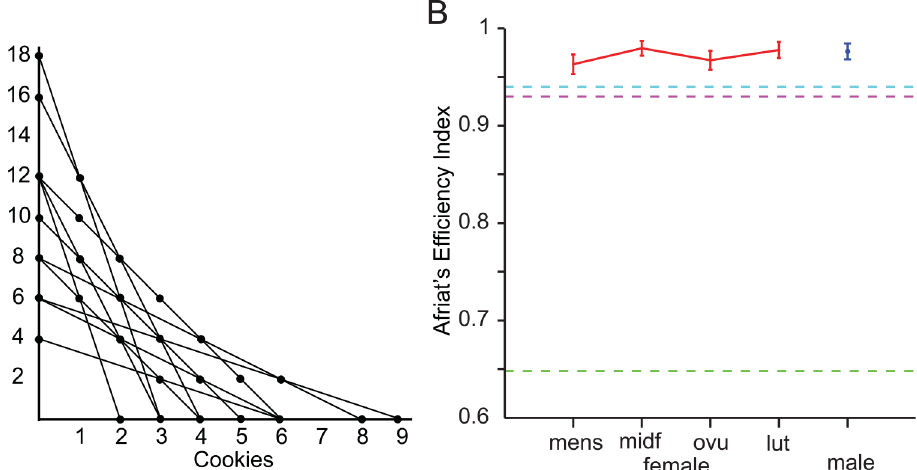
Fig 2. Results from the GARP experiment. (A) Budget sets used in the GARP experiment. Each line represents one budget set and circles on the line represent the bundles (or options) amongst which the subject can make a selection. ( B) Rationality across the menstrual cycle. Measures of the Afriat ’ s Efficiency Index are plotted for subjects in each menstrual cycle phase and for an age-matched male control population (both n = 36 subjects). Measures for all phases were above 0.95, the common threshold for rationality, and not significantly differently across phases or compared to males (all p > 0.3). Error bars represent standard errors. The dotted lines represent the AEI measurements for a random chooser (green) second grader (pink) and undergraduate (cyan) from Harbaugh et al.